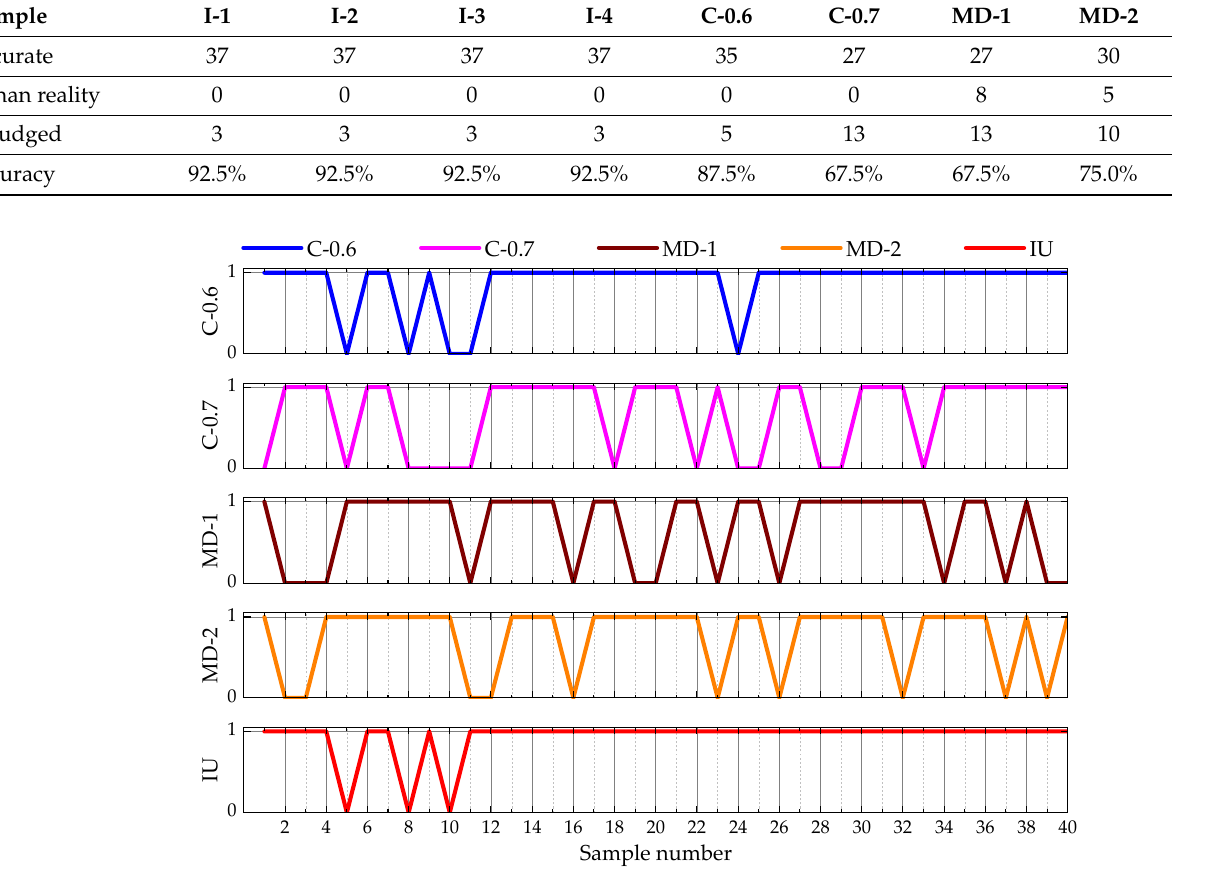
Figure 5. Comparison of prediction results of different models, where IU stands for the improved unascertained measurement obtained using the Minkowski distance formula in this paper, while 0 and 1 represent misjudgments and correct judgments, respectively.